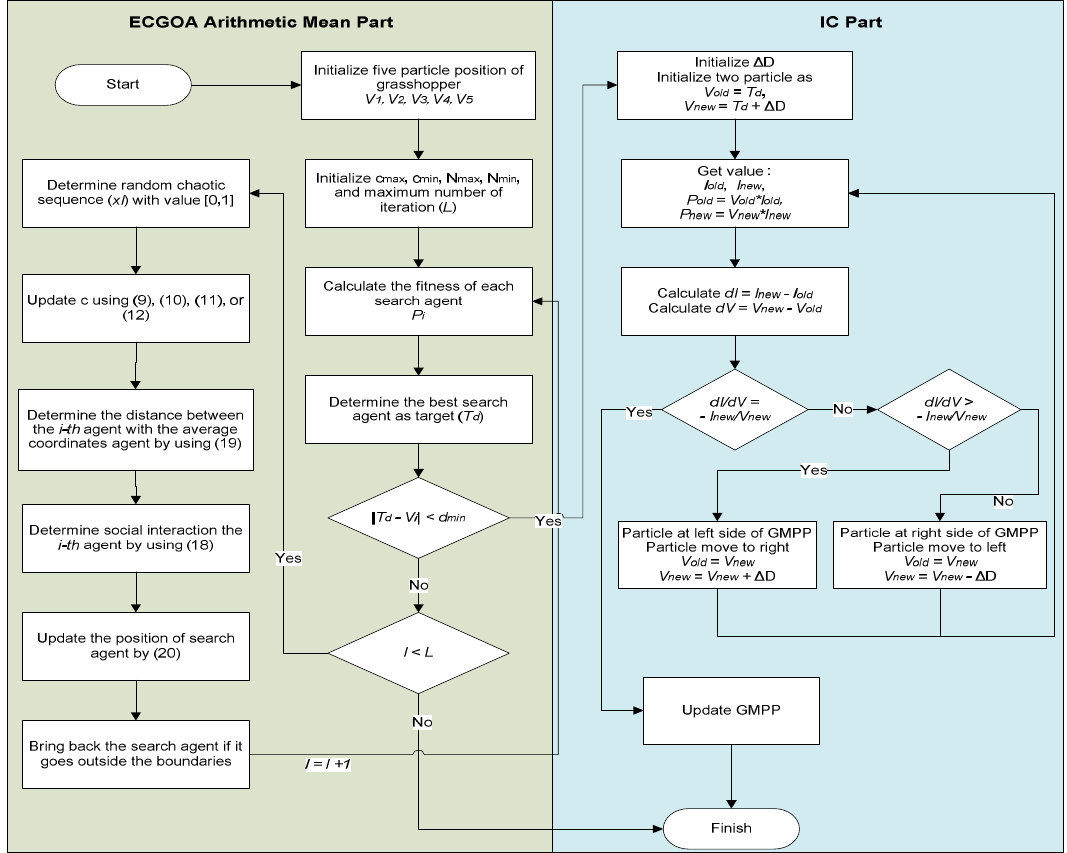
Figure 6. The flowchart of the proposed method.